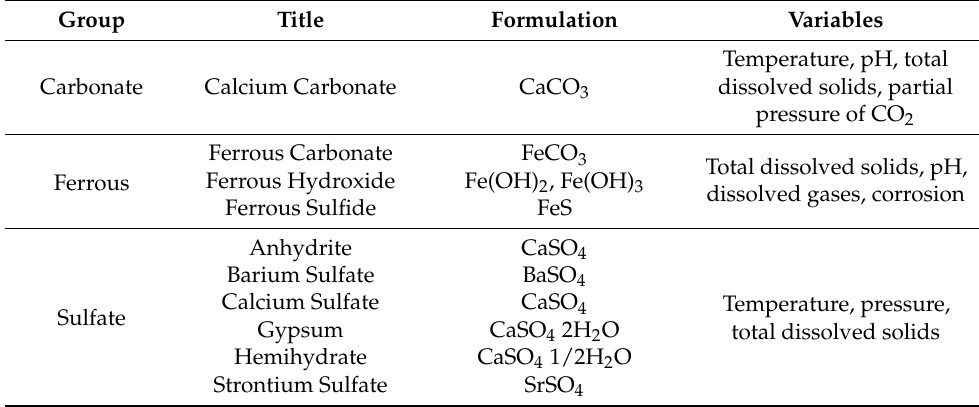
Table 1. Different inorganic solid scales